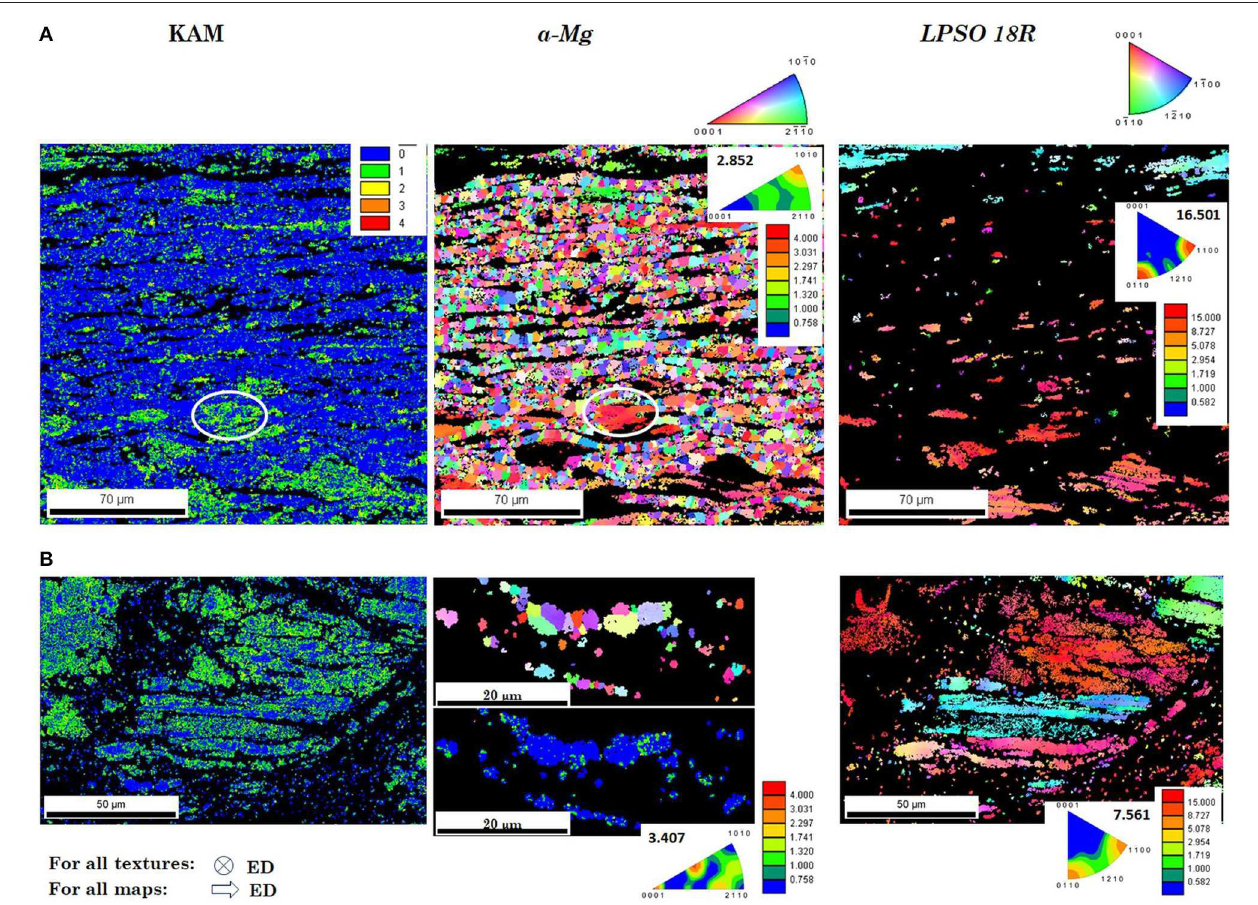
FIGURE 2 | EBSD maps for the S32 (A) and S85 (B) alloy in the as-extruded state: KAM analysis for entire map; separated orientation maps for the α -Mg and LPSO phase together with calculated texture for each fraction.